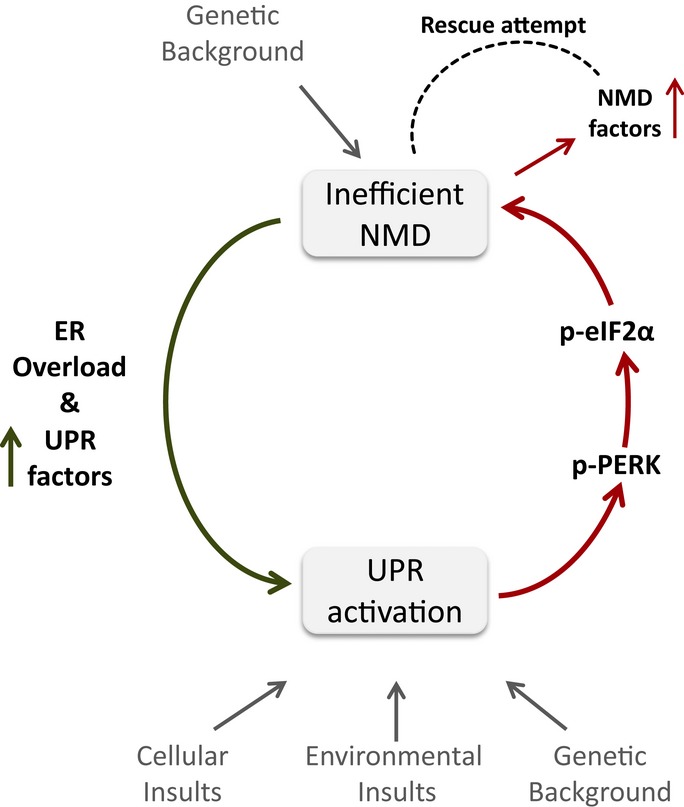
Feedback-loop regulatory network between the NMD and UPR pathways augments both the activation of the UPR and the attenuation of NMD and confers homeostasis under genetic, environmental, and/or cellular insults.